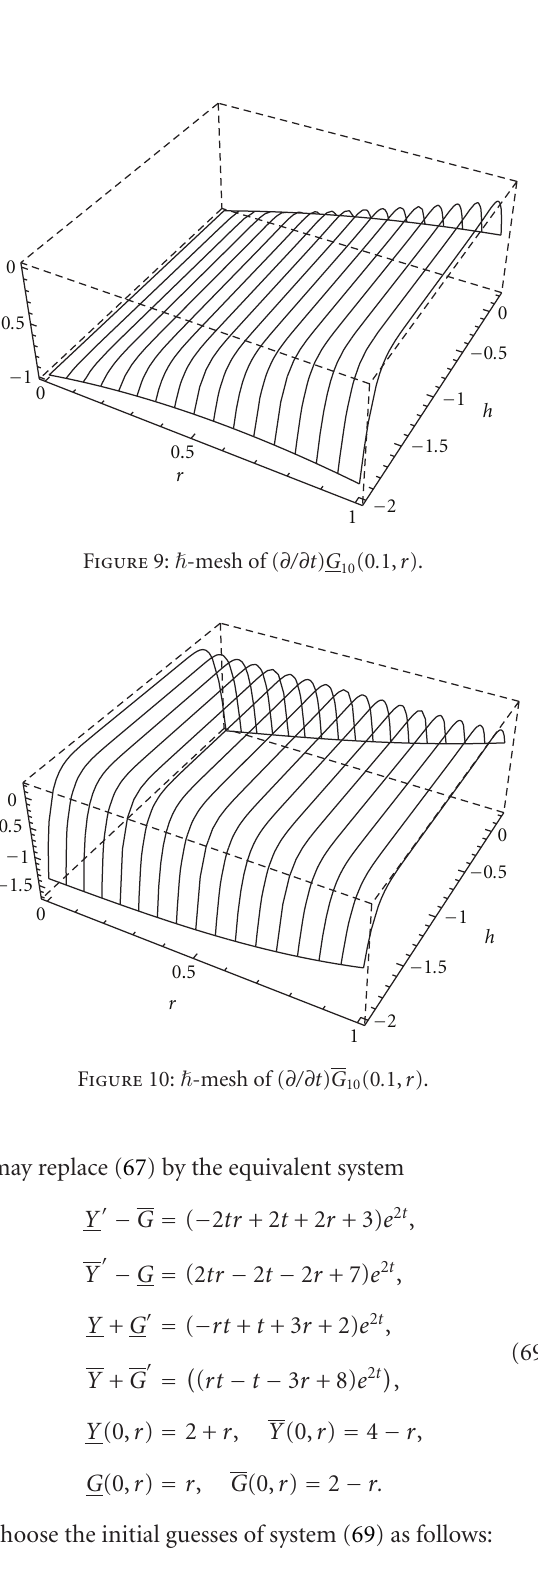
Figure 12: Contour plot of ( ∂ 3 /∂t 3 ) Y 10 (0, r